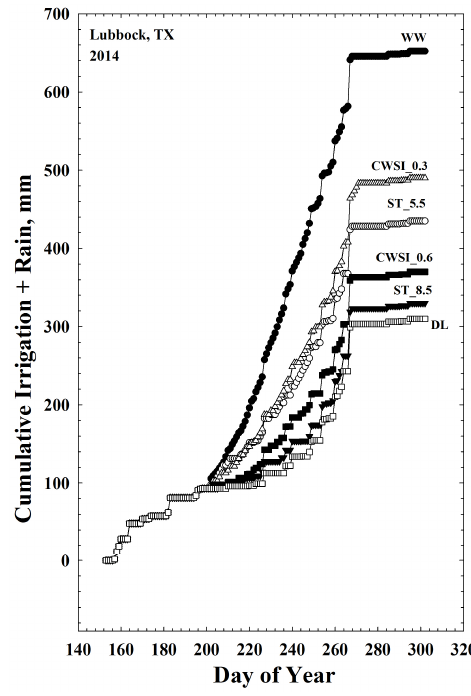
Figure 2. Seasonal trends in irrigation + rainfall for six water treatments: well-watered (WW), Stress Time (ST), 5.5 h (ST_5.5), Stress Time, 8.5 h (ST_8.5), Crop Water Stress Index 0.3 (CWSI_0.3), Crop Water Stress Index 0.6 (CWSI_0.6), and Dry Land